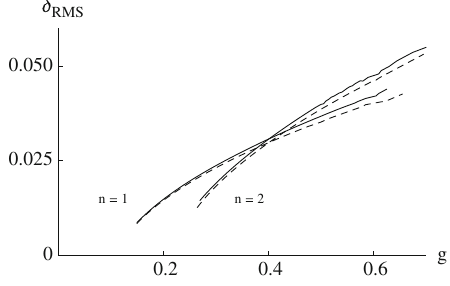
Right graph : solid and dashed curves depict negative fermionic bound energies in the dynamical and background model, respectively. In all graphs dotted lines depict the fermionic threshold energies in g /φ 0 → 0 limit